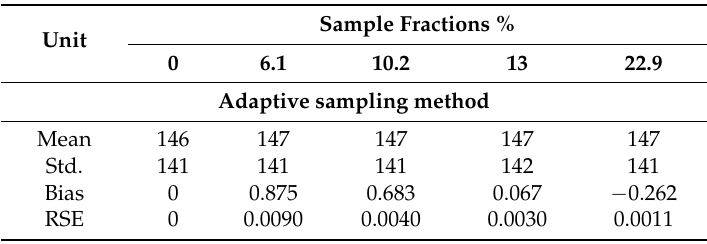
Figure 9. Typical results obtained from the developed adaptive technique: ( a ) measured Euclidean distance for jitter, ( b ) measured Euclidean distance for packet loss, ( c ) original traffic jitter, ( d ) sampled traffic percentage jitter, ( e ) original traffic packet loss ratio, and ( f ) sampled traffic packet loss ratio. Table 4. Measurement results for delay using different sampling methods: adaptive, systematic, random, and